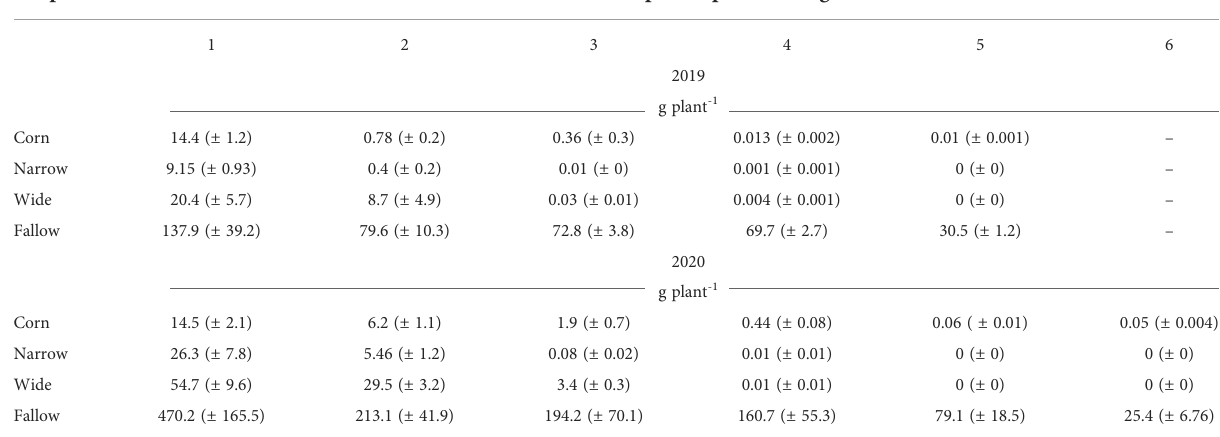
TABLE 3 The average biomass (g plant -1 ) of harvested waterhemp plants per each crop and transplant timing in 2019 and 2020, respectively. a .